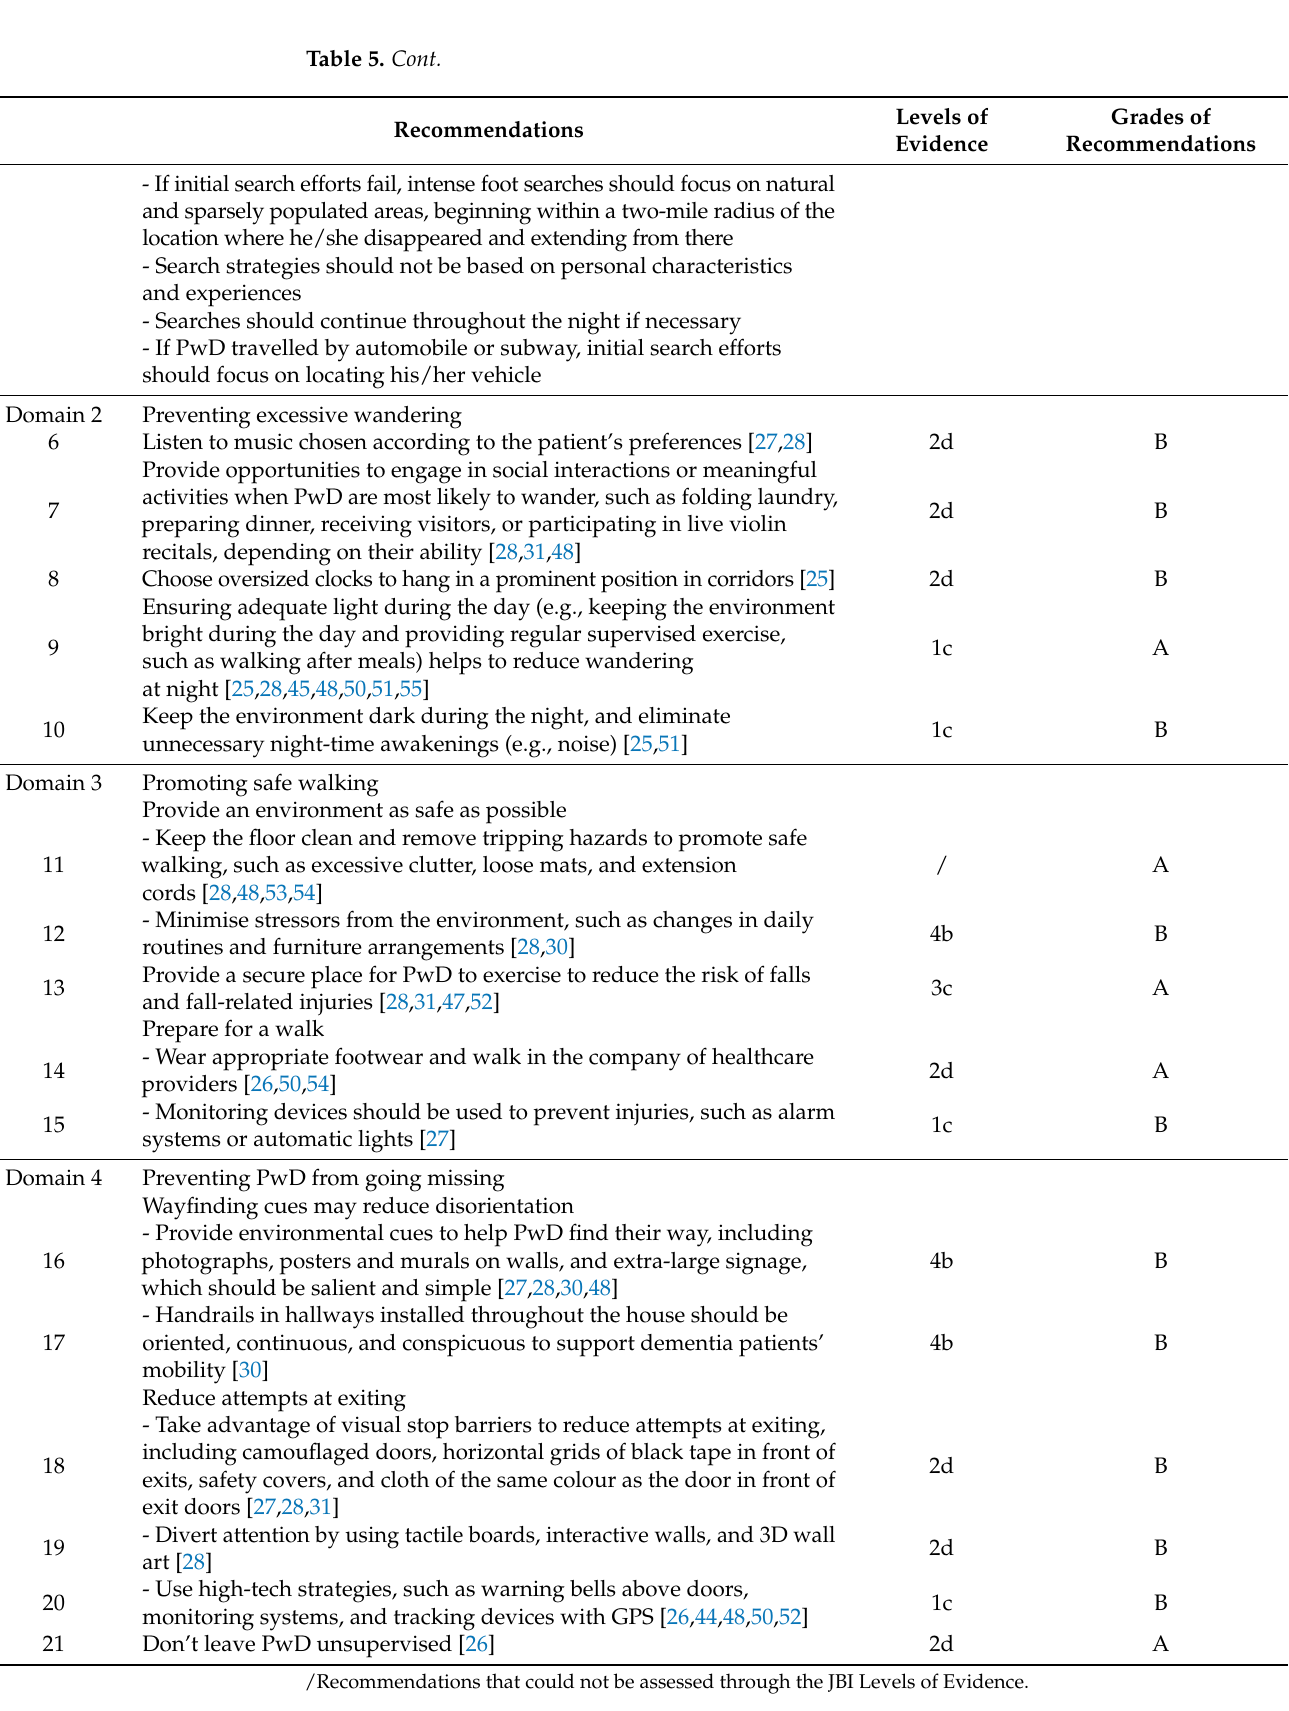
Table 5. Cont. Recommendations